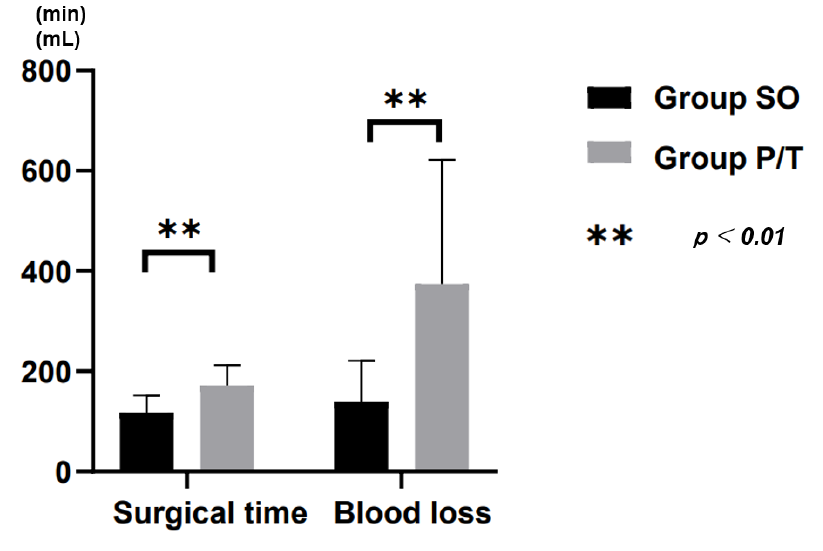
Figure 4. Surgical time and blood loss.